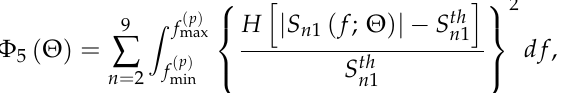
(cid:104) (cid:105) ( p ) ( p ) = [ 27.8, 29.0 ] (GHz), f , f max min